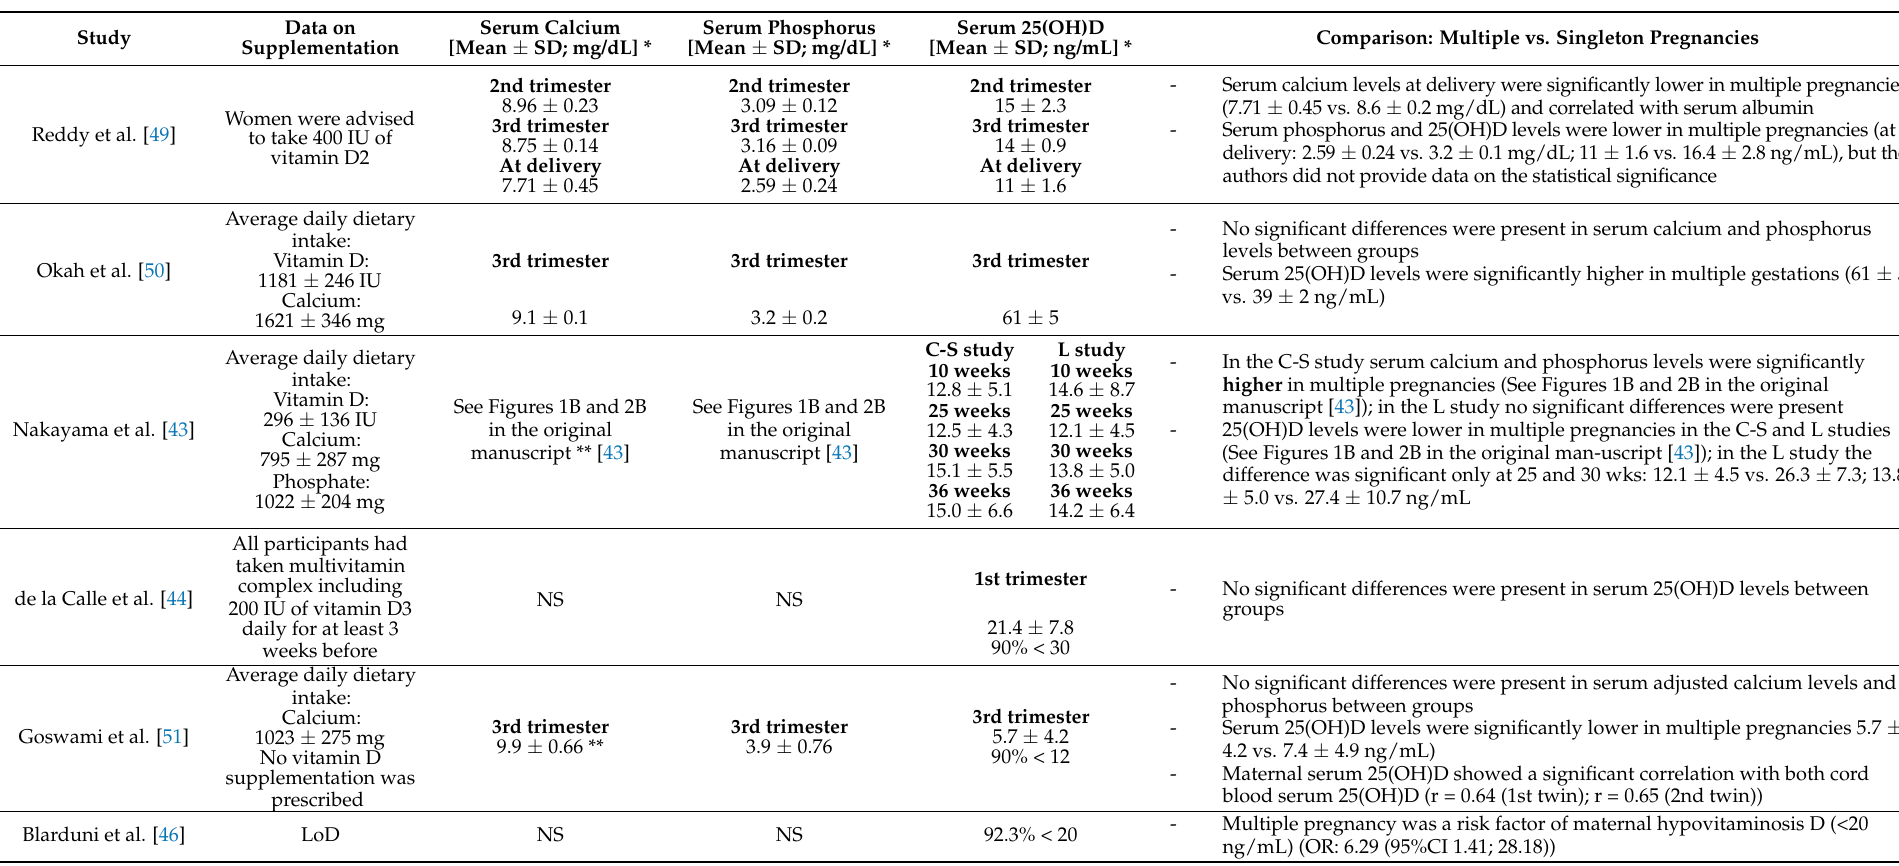
Table 4. Main results of the studies on calcium, phosphorus and vitamin D status in multiple